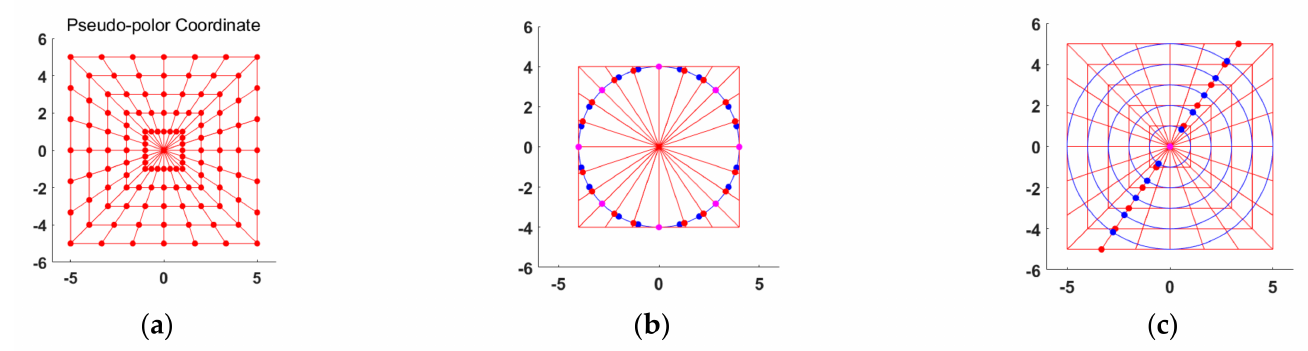
Figure 8. ( a ) Diagram of the pseudo polar grid. ( b ) Sketch of 1-D interpolations in the angular direction to obtain equisloped points. ( c ) Sketch of 1-D interpolations in the radial direction to square the